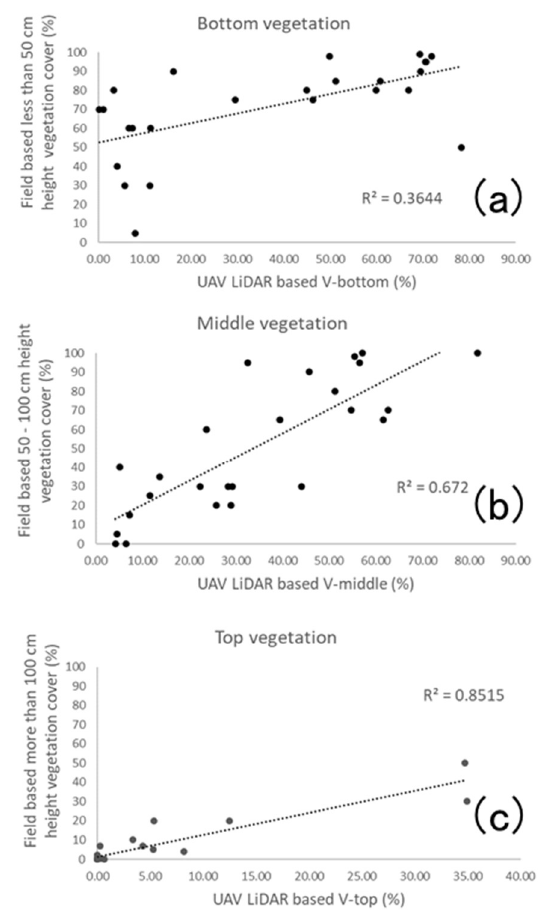
Figure 5. Comparison between UAV LiDAR based (a)V-bottom, (b)V-middle, (c)V-top and field based vegetation cover